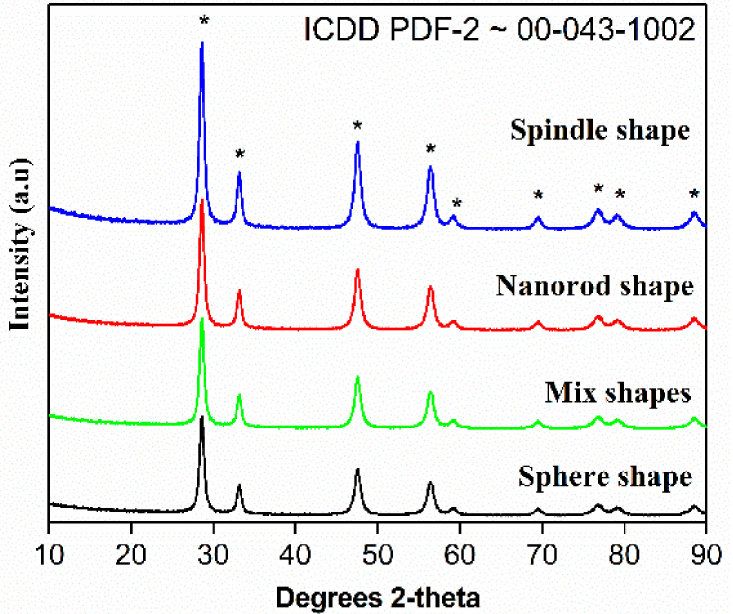
Figure 4. XRD patterns of the CeO 2 sphere; mixed shape CeO 2 ; CeO 2 spindle and CeO 2 nanorods prepared by annealing Ce(OH) 3 at 500 ◦ C for 3